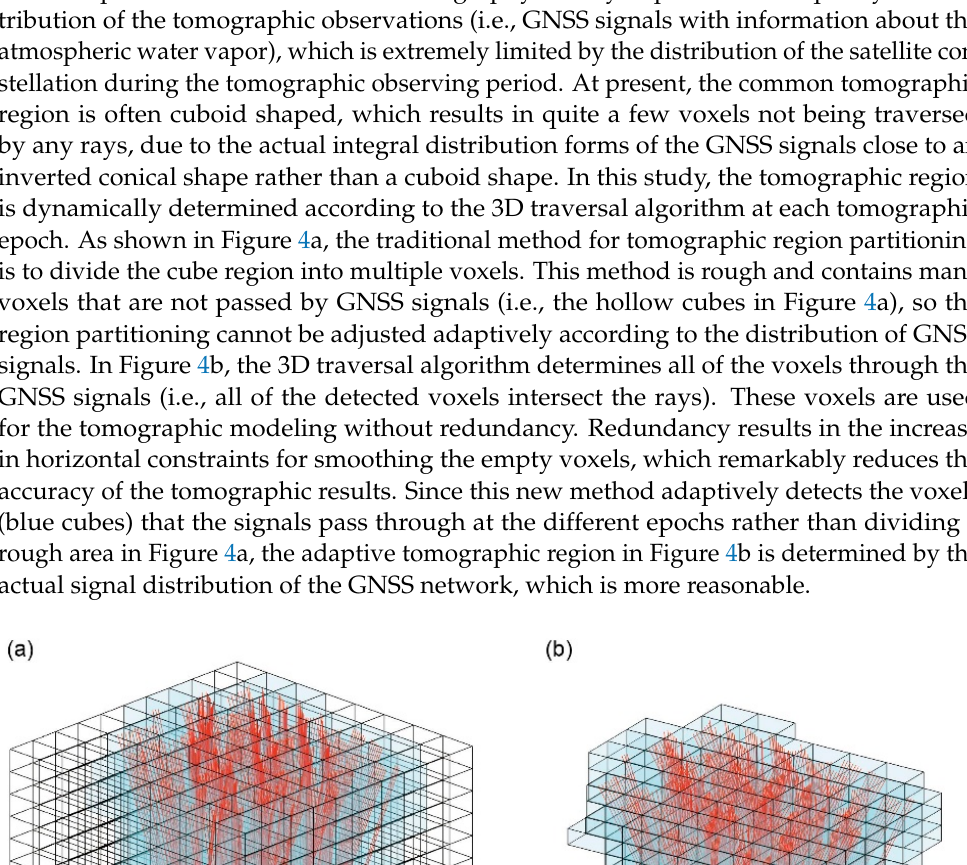
Figure 3. The 3D traversal algorithm is used to define the voxels (blue cubes) through the signal (red line).